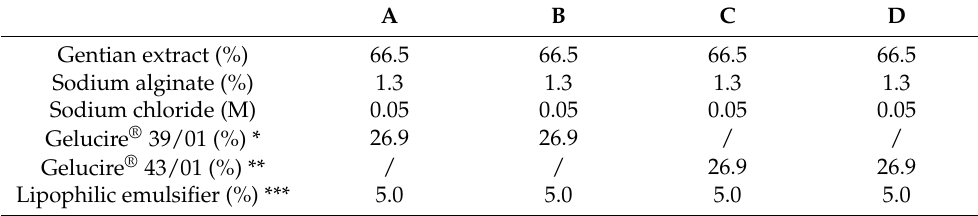
Figure 1. Process scheme. Table 1. A–D: The primary (W/O) emulsion composition.